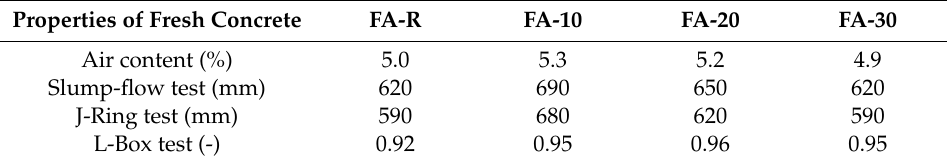
Table 6. Properties of the fresh